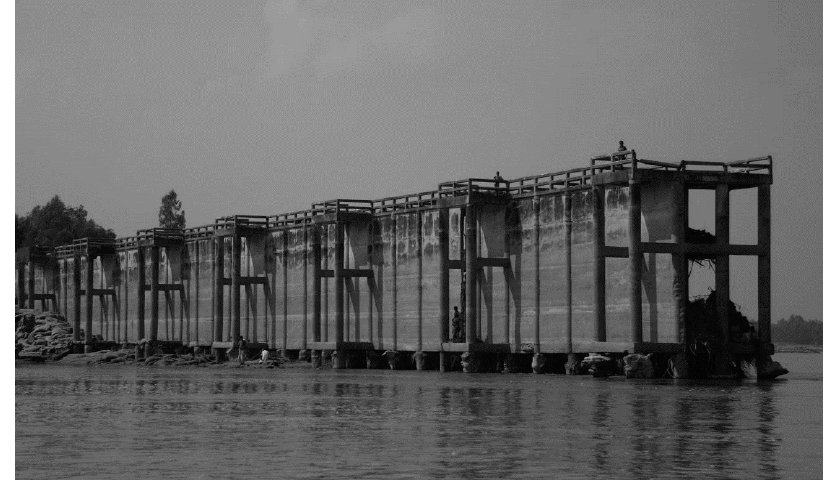
Figure 8. Shimla #2 RCC spur in November 2019—part of the end section has broken off and the protection has settled allowing flow underneath the wall (photo: author).